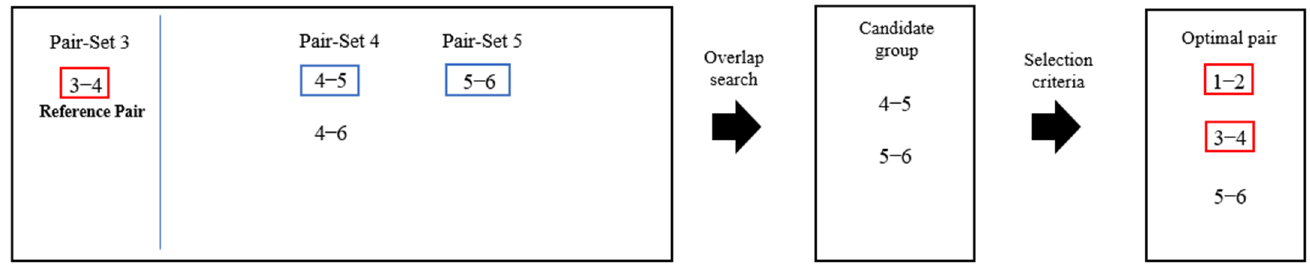
Figure 7. The second iteration for optimal pair composition in a strip .